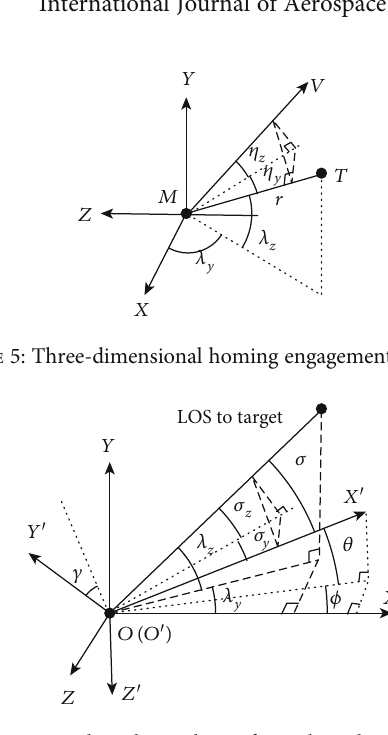
Figure 6: Angular relationships of missile and target in